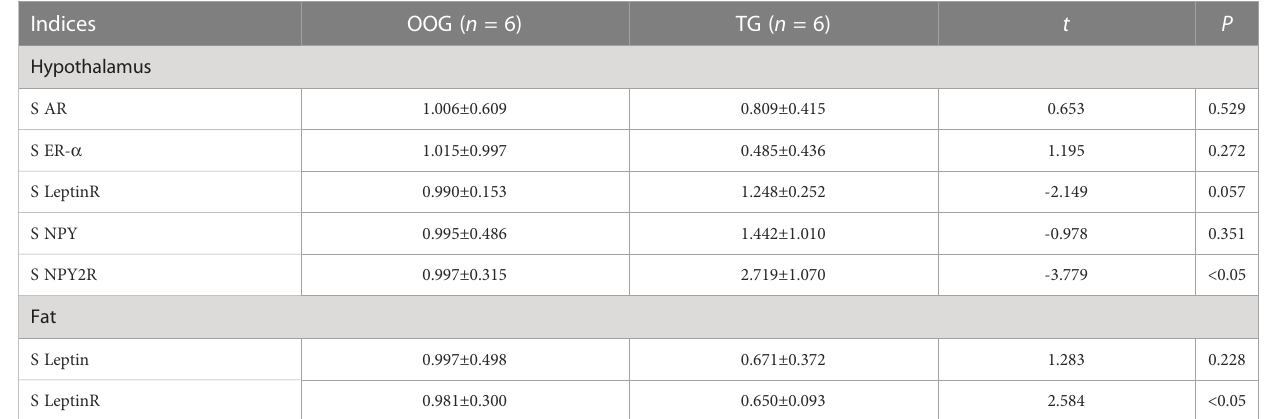
TABLE 4 Comparison of the content of functional gene mRNA in male offspring between OOG and TG ( (cid:1) x ± s ).